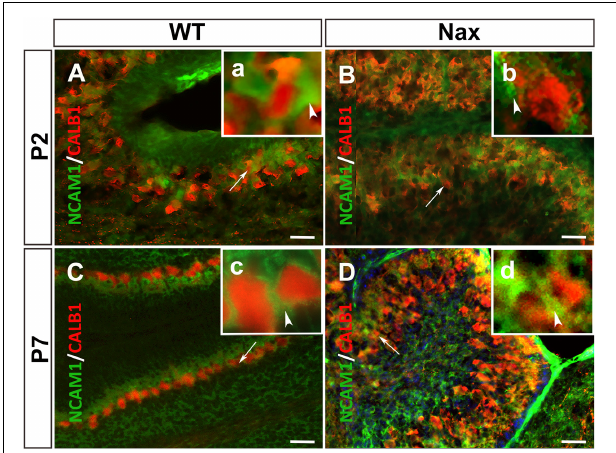
FIGURE 4 | PCs and the expression of NCAM1 in wt and nax cerebellar cortex. (A,B) Sagittal sections through the cerebellum immunostained with anti- calbindin (red) and anti-NCAM1 (green) shows the colocalization of PCs (red arrowhead in higher magnification a ) and NCAM1 (arrowhead in higher magnification b ) at P2 in both wt (A) and nax (B) cerebellum. (C,D) Images at P7 similarly shows the intercellular expression of NCAM1 not only in PC layer of wt (C) cerebellum but also in nax (D) cerebellum where the multilayer PCs are invaded into the molecular layer; (c,d) Higher magnification of the local NCAM1 expression. PCs, Purkinje cells. Scale bars: A = 50 µ m (applies to panels A–D